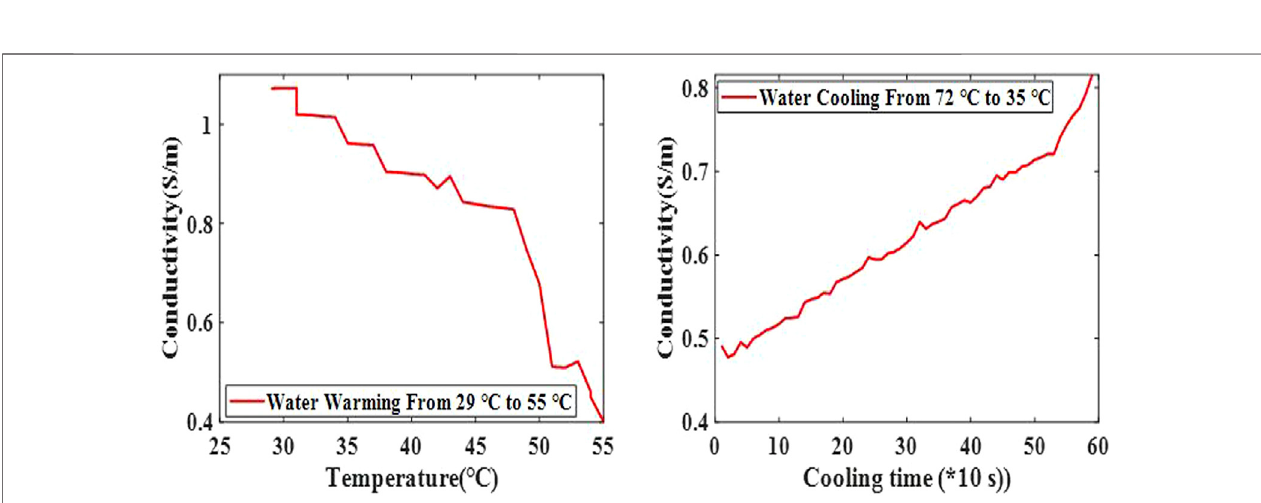
FIGURE 2 | Conductivity changes of pure water with temperature. The conductivity of pure water decreased gradually in the heating process and increased gradually in the cooling process.